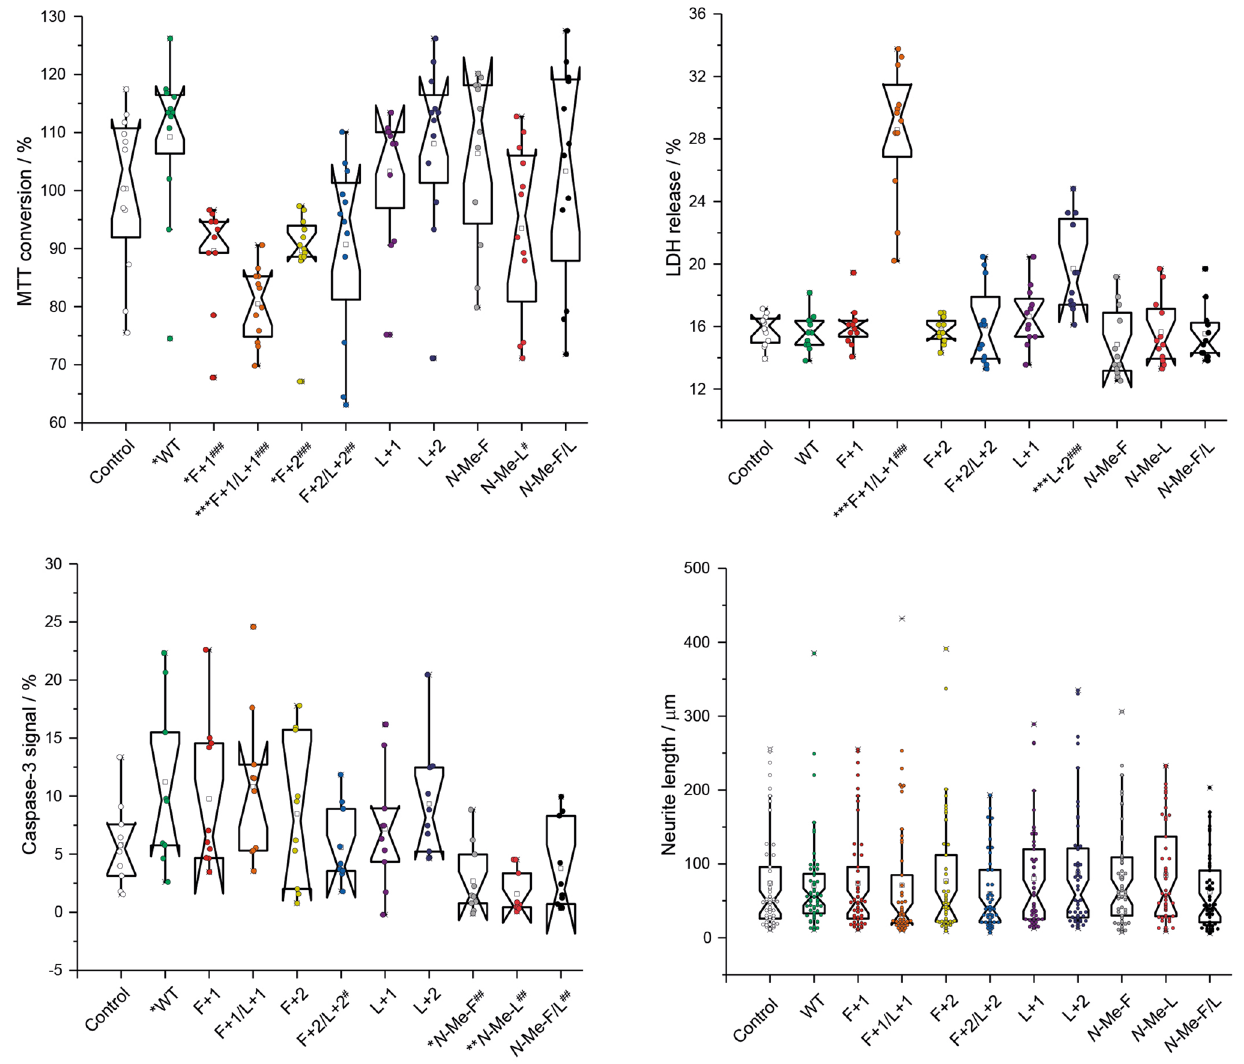
Figure 8. Box plots showing results from toxicity studies of all Aβ 40 peptide variants. The MTT conversion assay (upper left) represents the proportion of metabolically active cells (alive) upon exposure to Aβ 40 peptide variants; the LDH release (upper right) is indicative for plasma membrane disruption (dead cells) under the same conditions; caspase-3 staining (bottom left) is used to investigate one of the possible pathways towards cell apoptosis; neurite length (bottom right) measurements are used to examine the effect of all Aβ 40 peptide variants on the outgrowth of neurites and thus the wellbeing under the applied conditions. Mutant F+1/L+1 stands out in MTT and LDH, while in the caspase-3 staining the N -methylated variants show protective effects. The neurite outgrowth behavior is not significantly impacted by any of the mutants. Significance was tested applying a heteroscedastic Student’s t-Test using two-tailed distributions, *p ≤ 0.05; **p ≤ 0.01; ***p ≤ 0.001 vs control; # vs WT